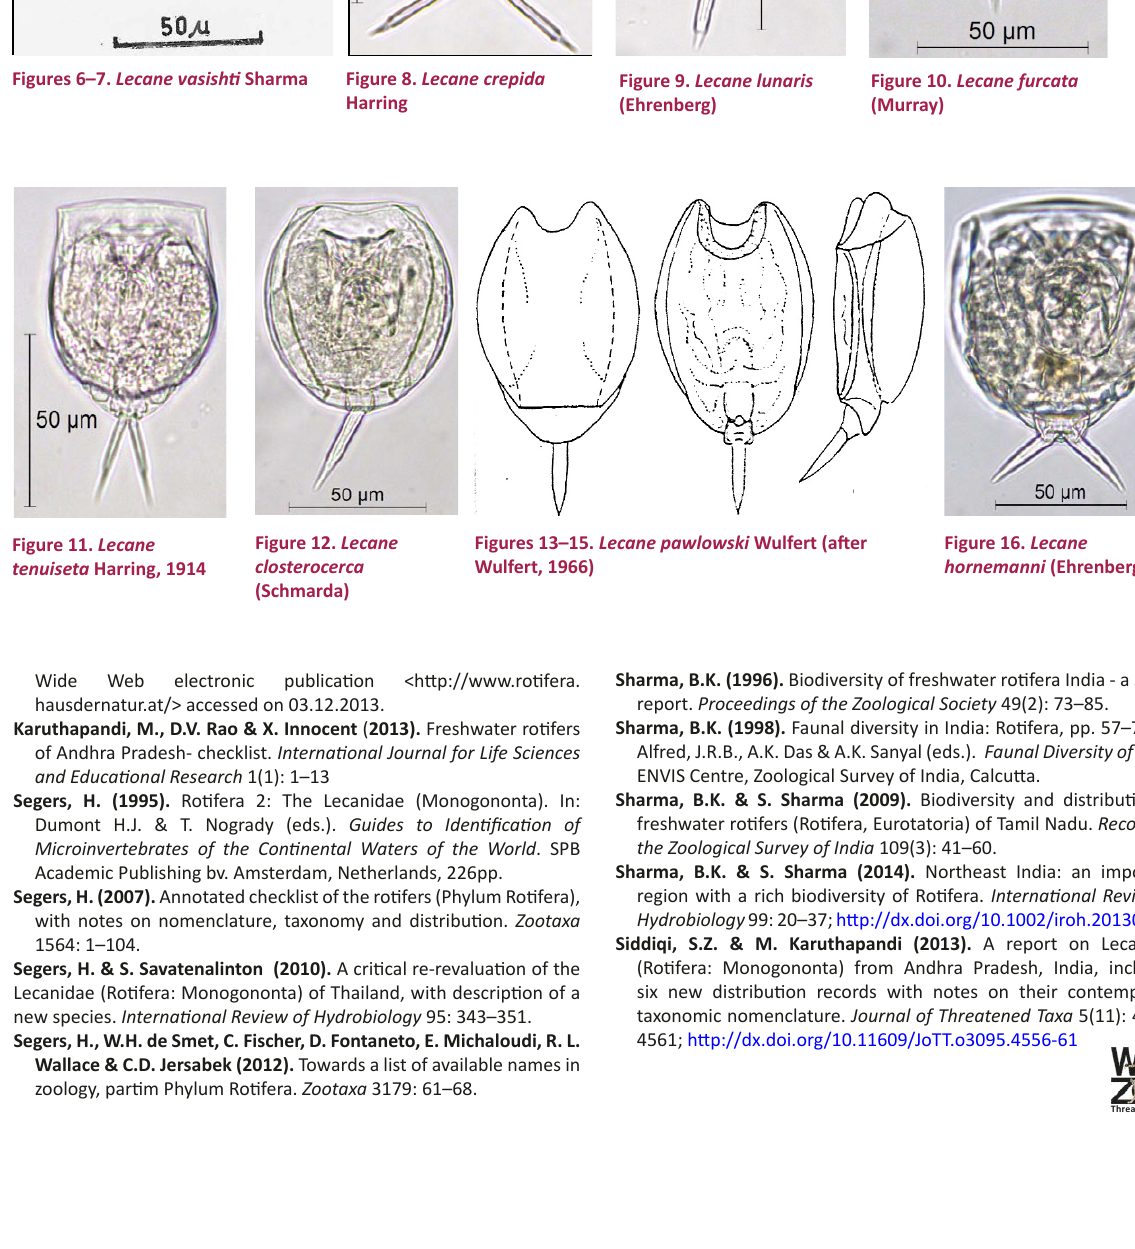
Figure 9. Lecane lunaris (Ehrenberg)